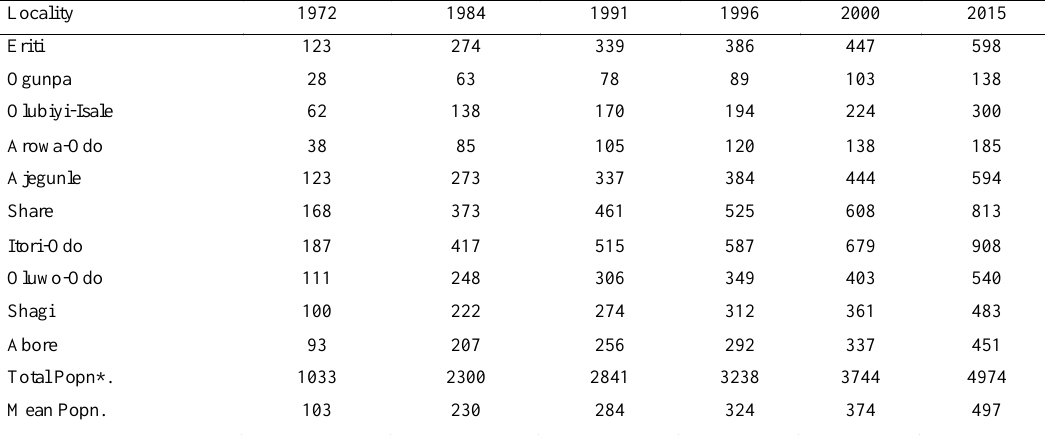
Table 3: Population estimation for years 1972, 1984, 2000 and 2015 (Adeleke, 2017)